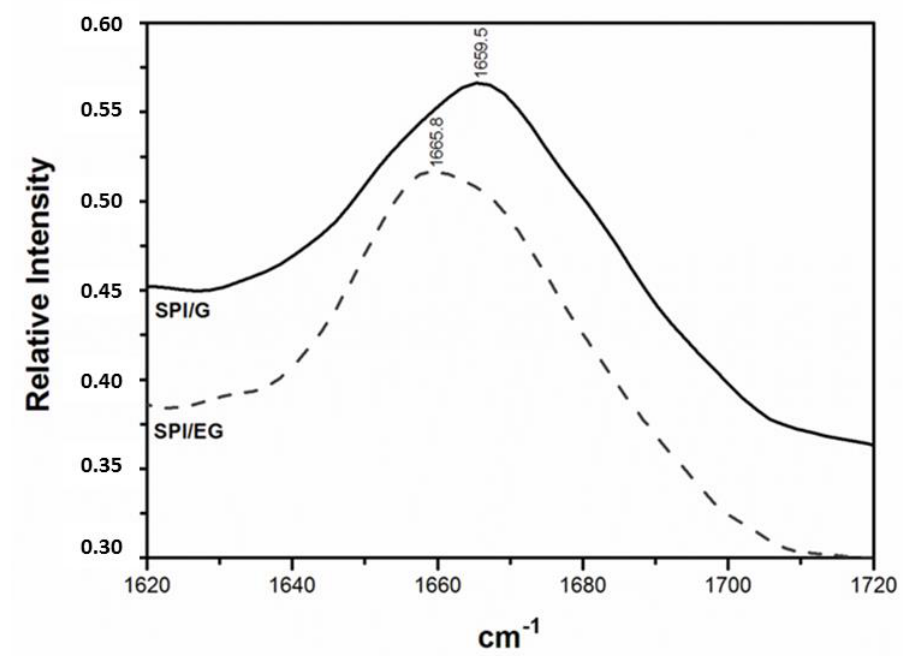
Figure 1. Raman spectra in the 1620–1720 cm − 1 region of oil-free SPI gels (SPI/G) and SPI emulsion gels with chia oil (SPI/EG). See Table 1 for sample formulation.